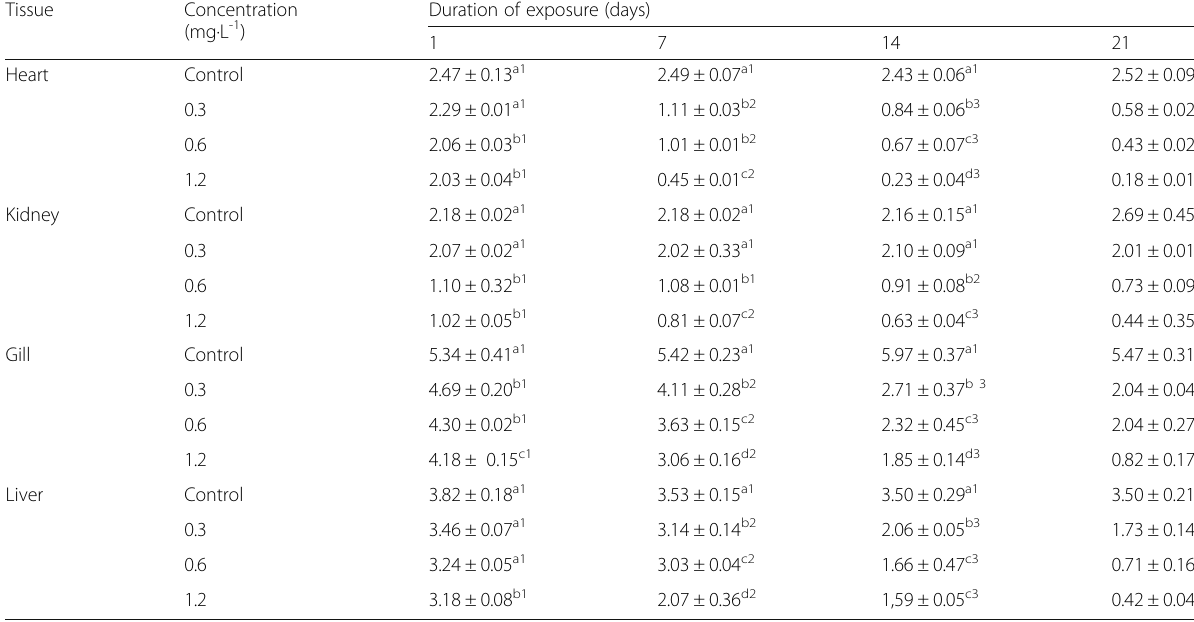
Na + /K + activity is expressed as micromole Pi per minute per milligram protein. Values=mean±SD ( n =3 determinations).Values in the same column with different superscript letters differ significantly between different concentrations. Values in the row with different numeric superscripts are significantly different with duration within the same concentration; p